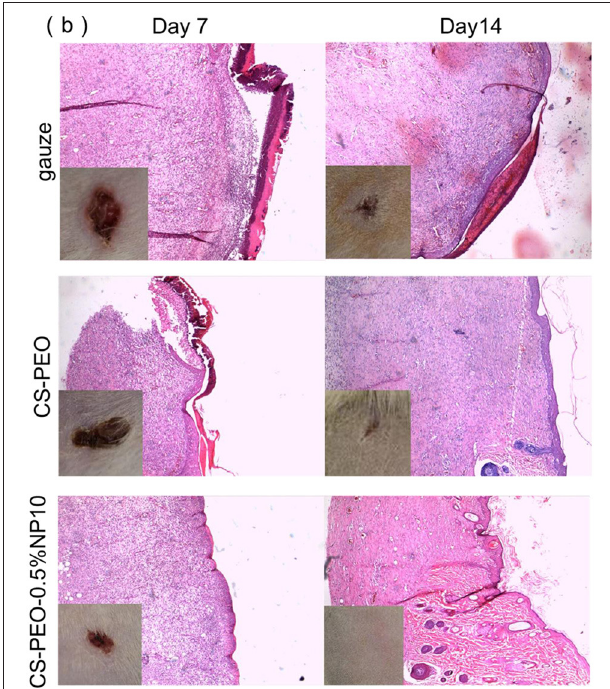
FIGURE 5 | Animal models of wounds infected by S. aureus . Histological images indicate skin tissues stained by H&E dissected in the post-operative day 7 and day 14. Inserted photos show the macroscopic morphologies of wounds. The control groups are treated with wound dressings of gauze, and CS-PEO nanofibers, while the experimental group is treated with CS-PEO-0.5% NP10 nanofibers as a wound dressing.